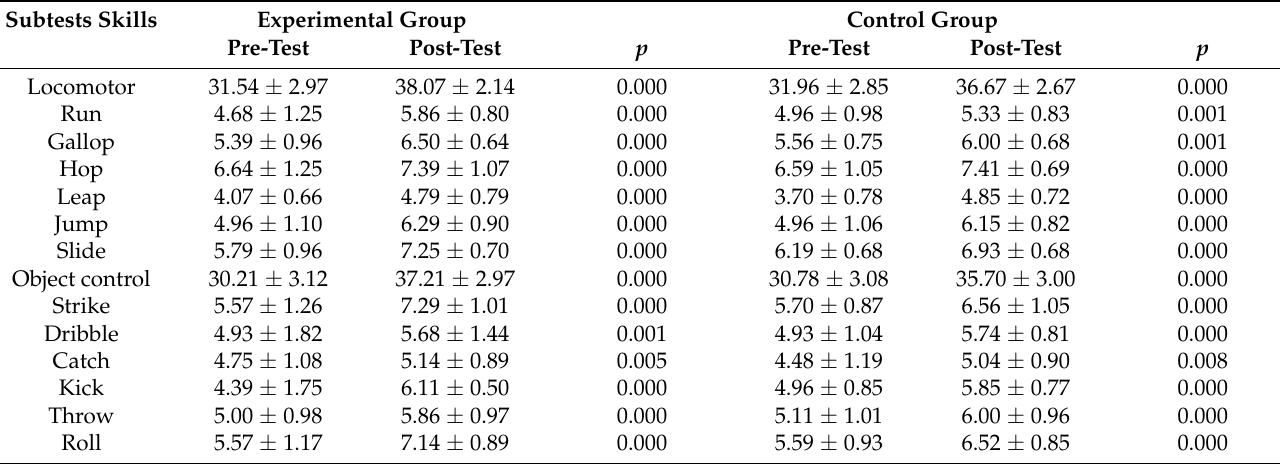
Table 1. Mean and standard deviation (SD) of the experimental and control groups in the pre- and post-tests. Subtests Skills Experimental Group Control Group Pre-Test Post-Test p Pre-Test